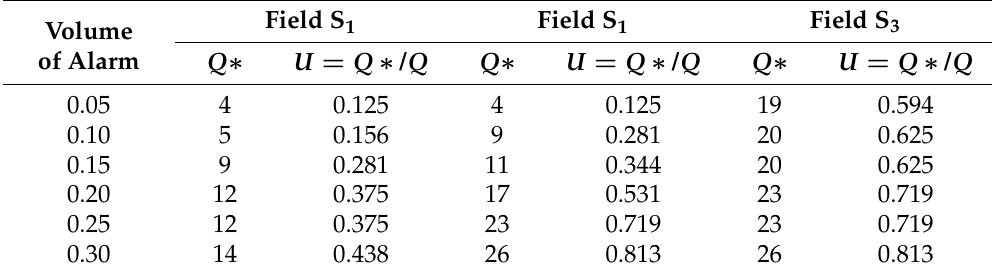
Table 3. Estimates of prediction of the quality of detecting target earthquakes based on the fields of density of earthquake epicenters S 1 , S 2 , and S 3 . Q ∗ —number of detected target events; U —estimation of detection